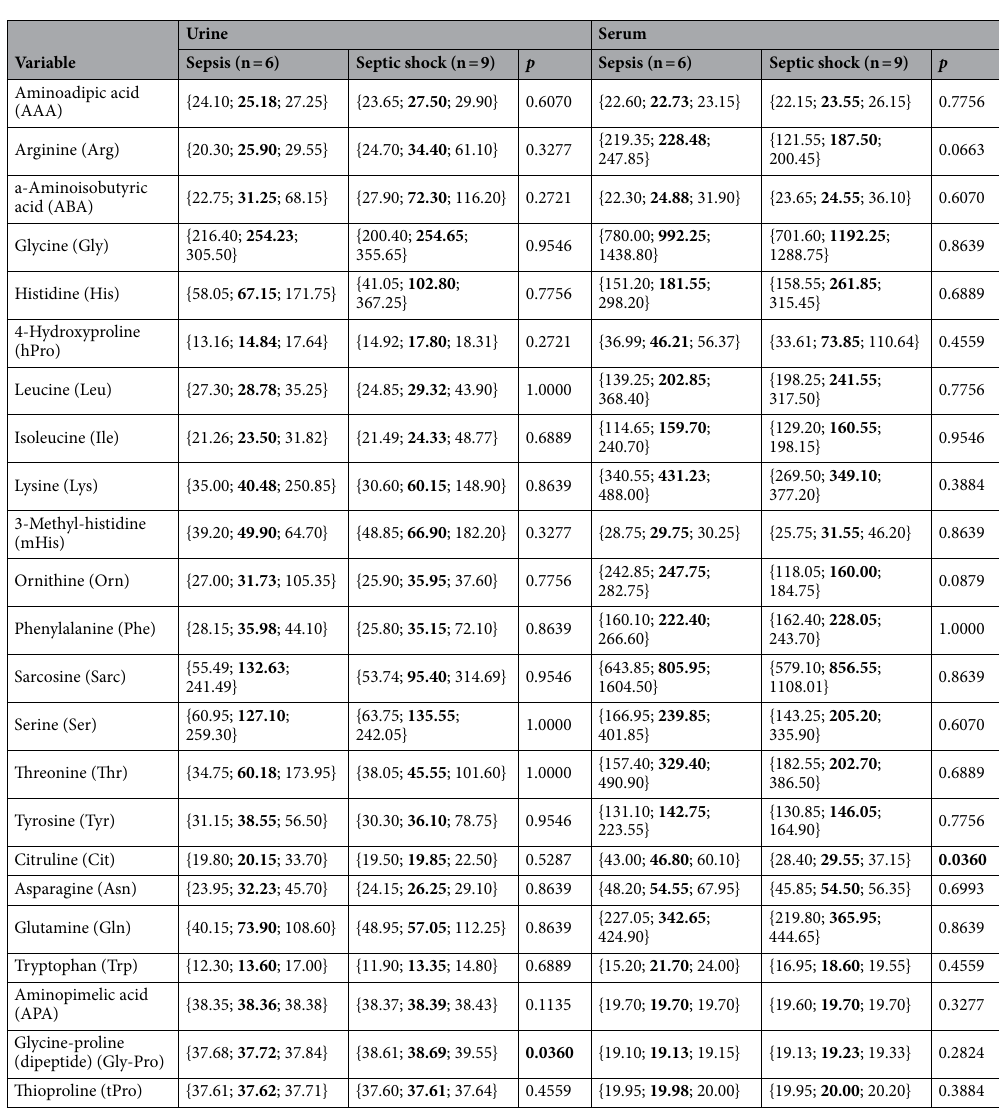
Table 2. A comparison of the amino acids in the urine and serum in sepsis and septic shock. Data is presented as {1st quartile; median value; 3rd quartile}; cases in which p < 0.05 (U Mann–Whitney test) are marked in bold. The median value is expressed as